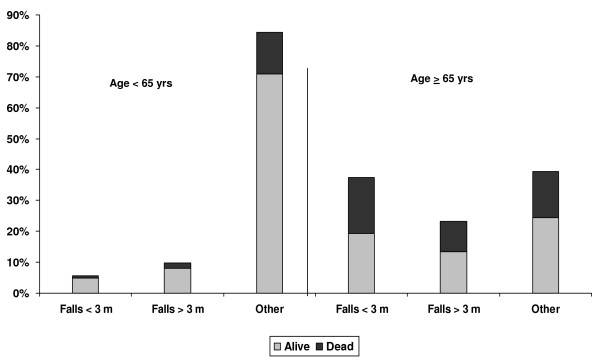
Two-week Mortality by Mechanism of Injury and Age Group.